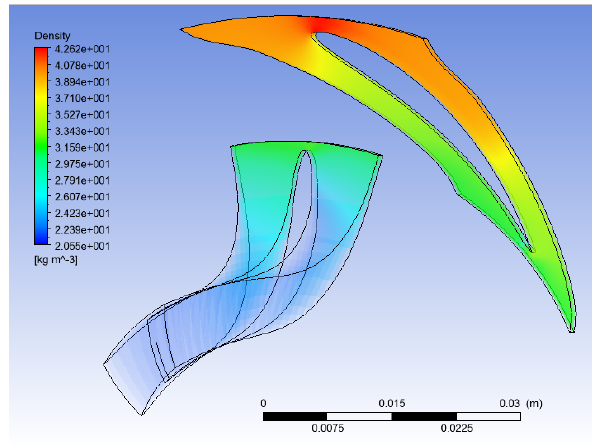
Figure 28. CFD study results: Density (R245fa).